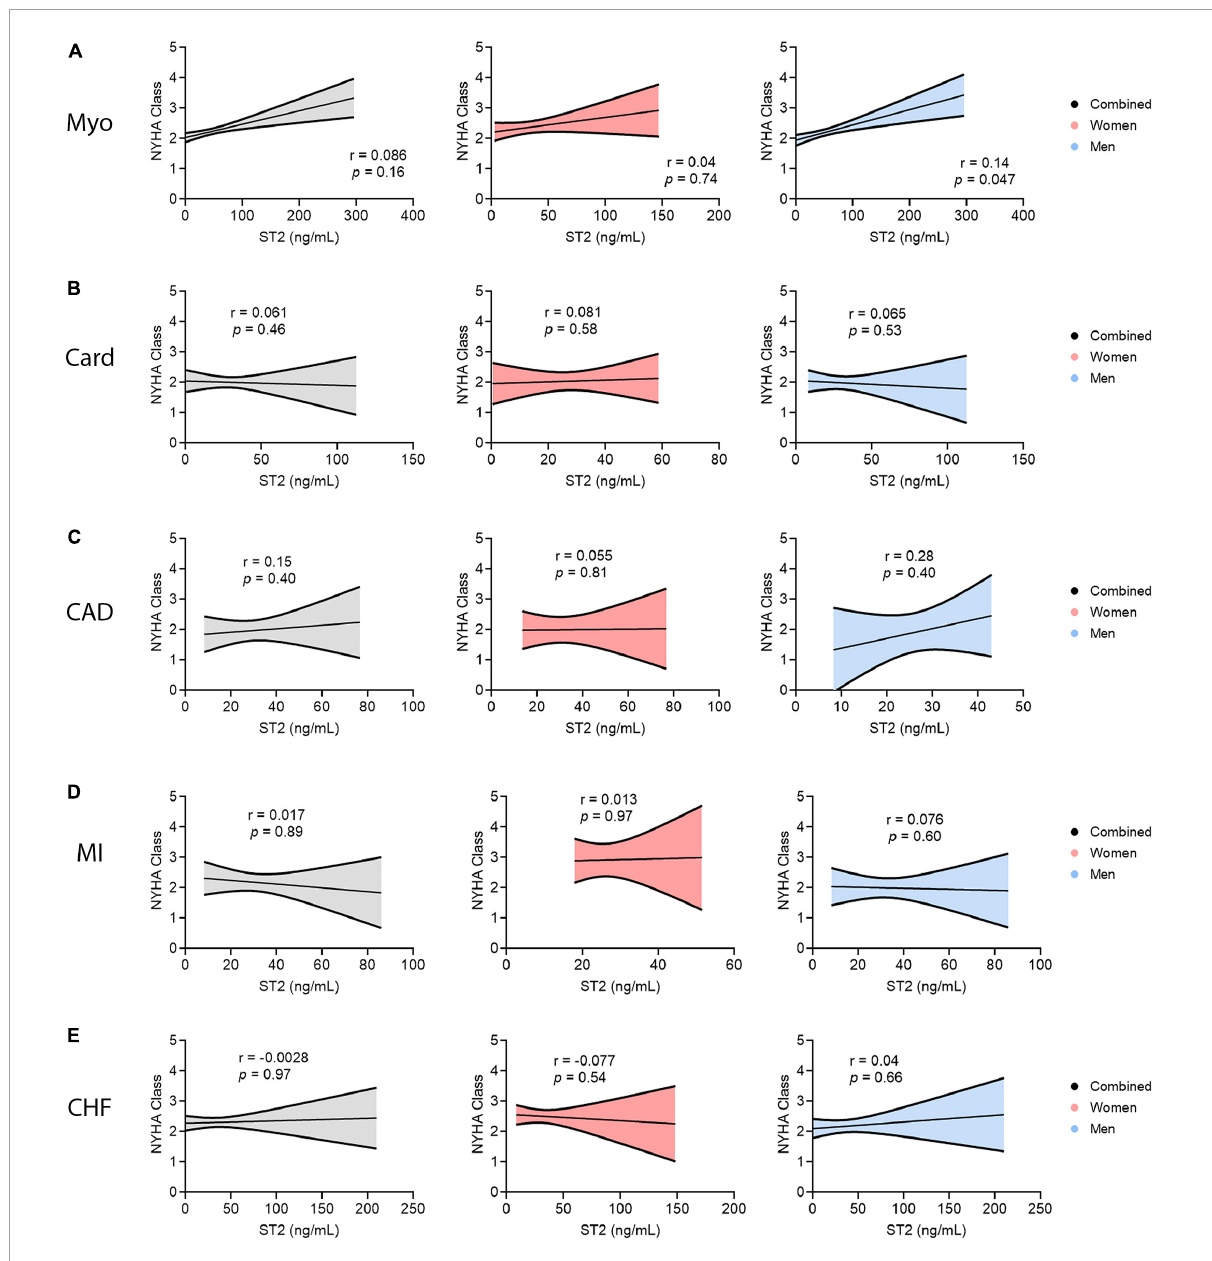
FIGURE10 Soluble ST2 (sST2) relationship to NYHA class by sex. sST2 levels compared women (peach) vs. men (blue) with New York Heart Association (NYHA) class I–II vs. III–IV heart failure for (A) myocarditis (Myo), (B) cardiomyopathy (Card), (C) coronary artery disease (CAD), (D) myocardial infarction (MI), or (E) congestive heart failure (CHF). Data show simple linear regression of data for each group with 95% confidence intervals showing spread of certainty in the model. P -values were calculated using 2-tailed Pearson